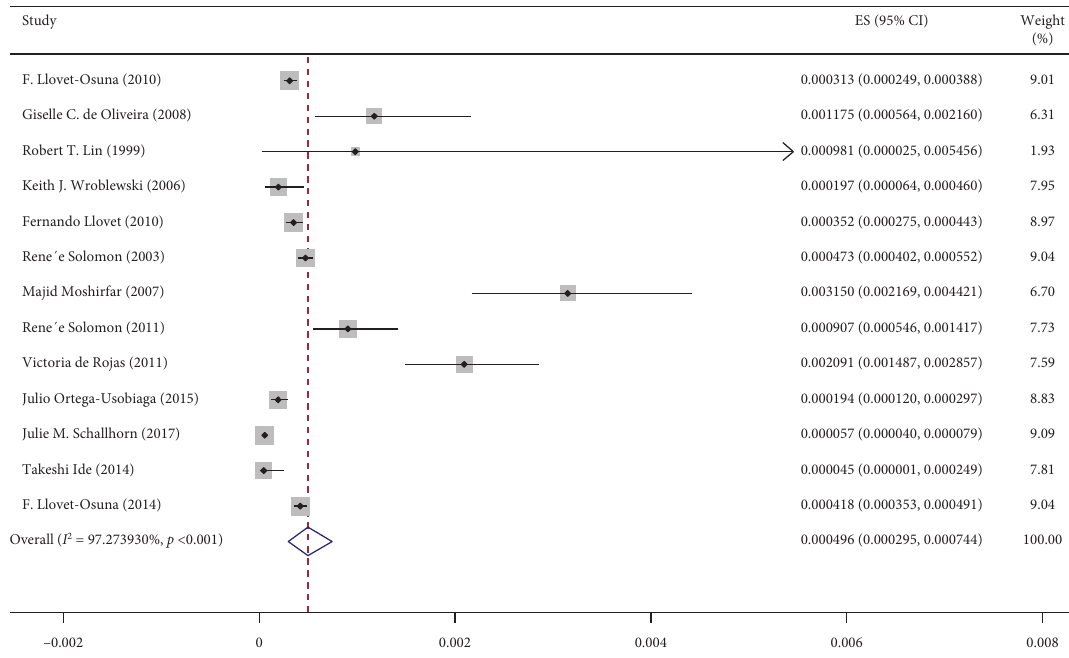
Figure 2: The incidence of infectious keratitis after performing the keratorefractive surgery, according to the author’s name and the year of research, based on the random effects model. The midpoint of each line segment reveals the incidence of infectious keratitis after conducting the keratorefractive surgery for each study. The rhombus form also shows the incidence of infectious keratitis after performing the keratorefractive surgery for all